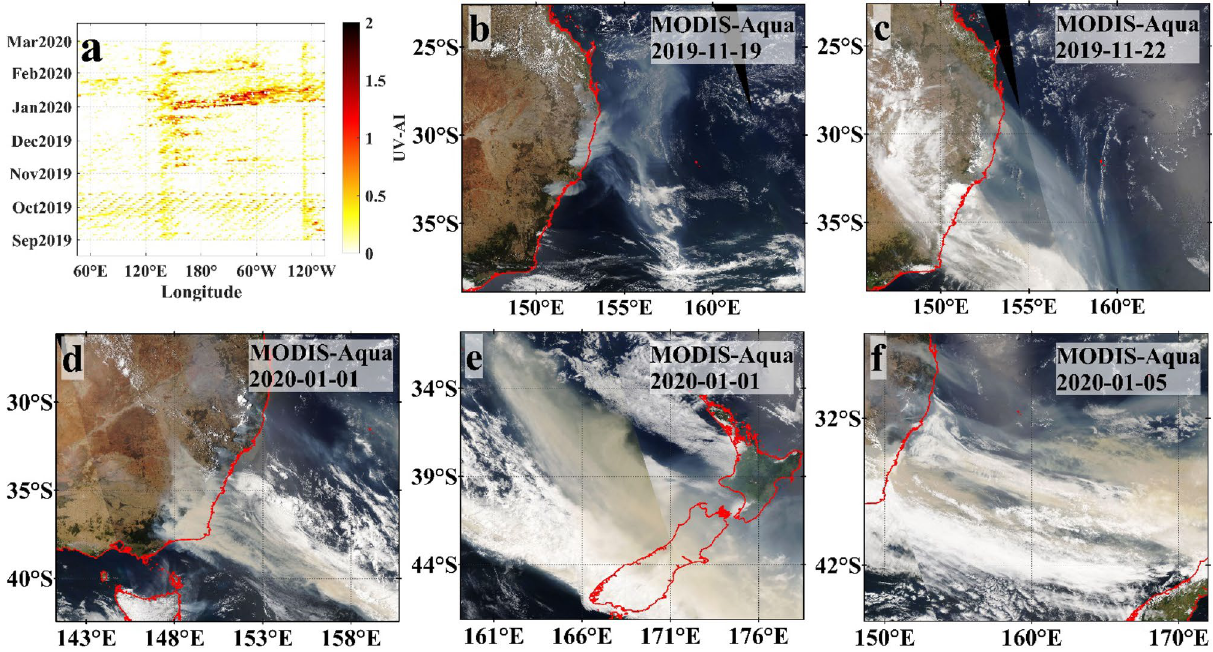
Figure 2. The Hovmoller latitude-averaged UVAI in the range of the black box in Fig. 1. MODIS Aqua reflectance images (true colour) of the atmospheric pollution observed by MODIS ( b , c ) on 19 and 22 November 2019 and ( d–f ) heavy particulate plumes covering the Tasman Sea and beyond. The coastline is shown in red lines. MODIS Aqua images were downloaded from the NASA Worldview website (https:// world view. earth data. nasa.